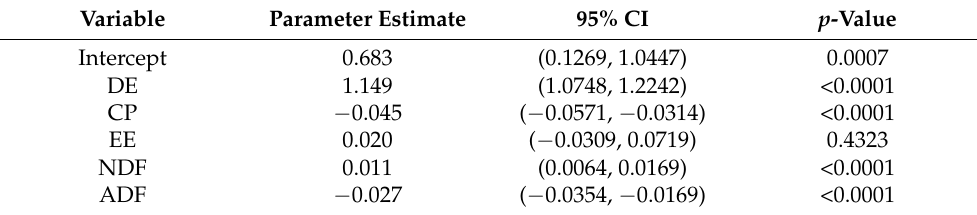
Figure 4. Residual analyses ( n = 141) of the predicted ME using simple linear regression (Equation (2)) with the EE ( a ), NDF ( b ) and ADF ( c ). DM; dry matter. Table 5. Metabolizable energy prediction from the digestible energy and feed nutrients using multiple regression